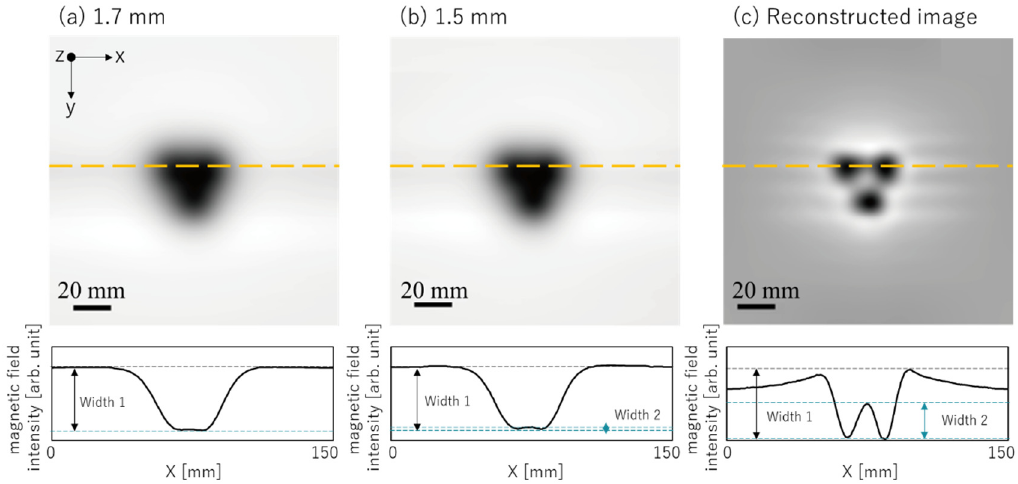
Figure 4. Two-dimensional magnetic particle distributions: I images and magnetic field intensity profiles measured at 1.7 mm ( a ) and 1.5 mm ( b ) distances from the magnetic source, and reconstruction I ( c ) based on Images I ( a ) and I ( b ).